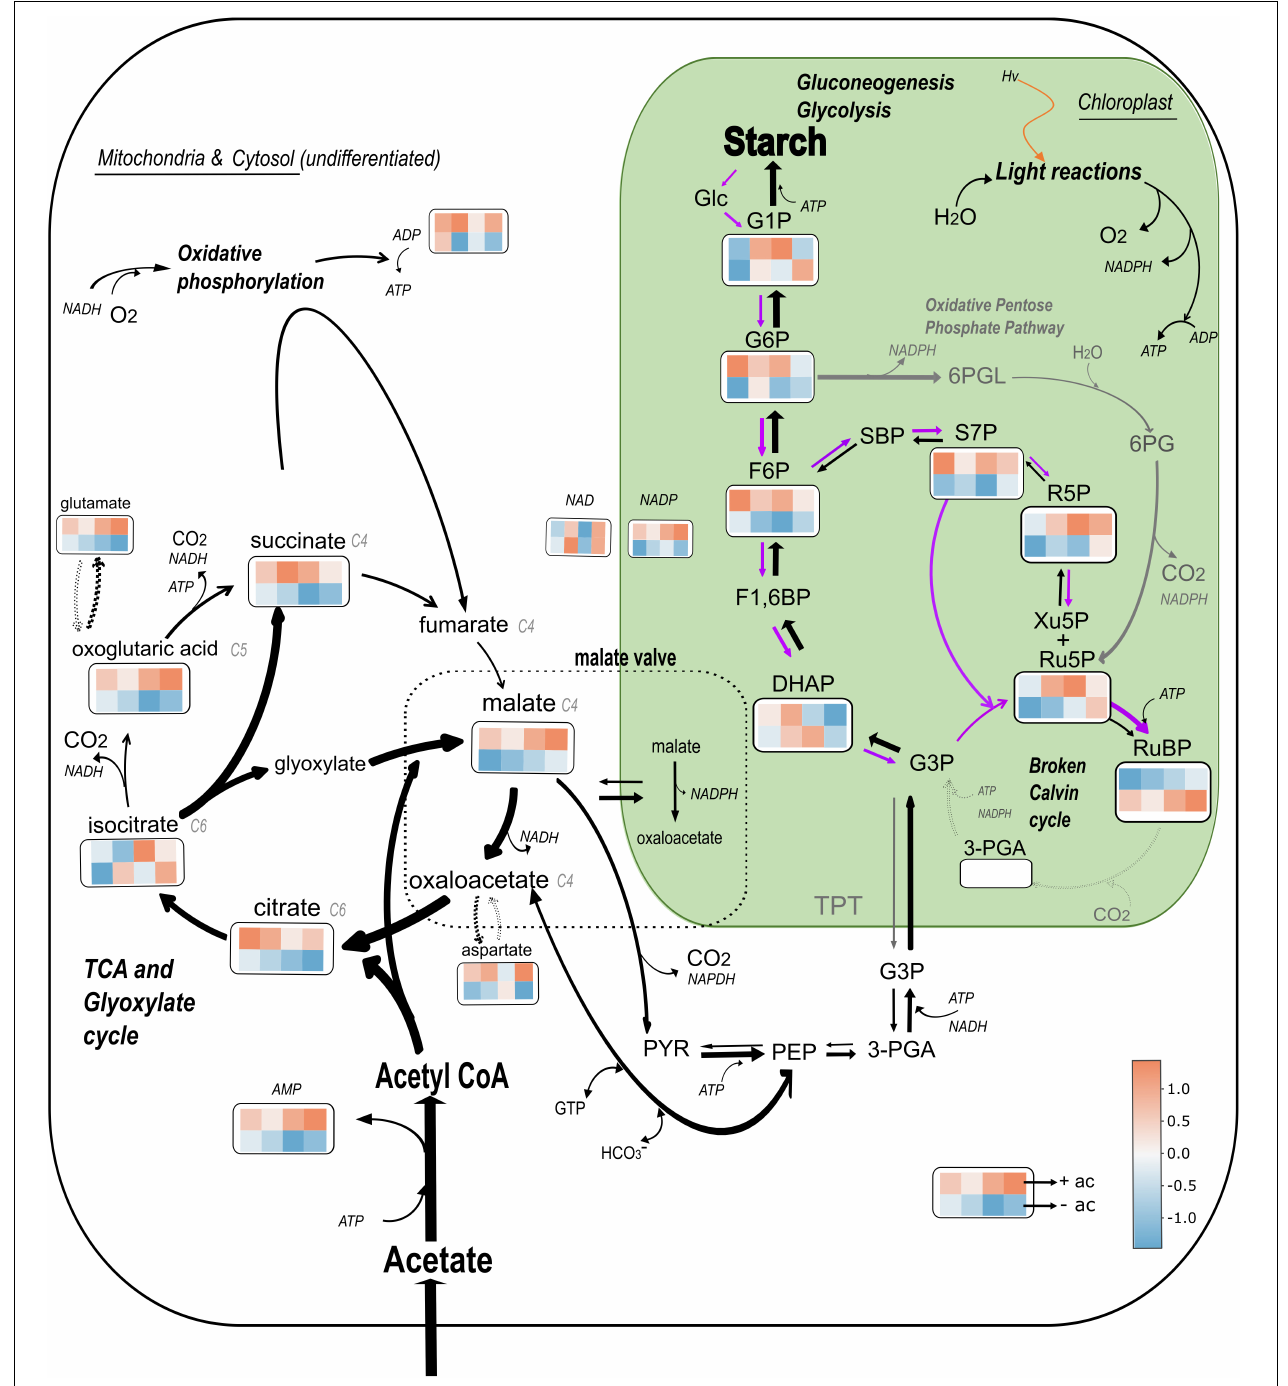
FIGURE 8 | Model of central C metabolism in Chlamydomonas reinhardtii (cid:49) rbcL mutant depending on the carbon status. The relative changes of the abundance of 19 metabolites is represented using colored squares extracted from a heatmap. The top four squares are replicates that represent metabolite abundance in presence of acetate, and the bottom four in absence of acetate, both after a 5 min light treatment (300 µ mol photons m − 2 s − 1 ). The major pathways shown are the glyoxylate and TCA cycles represented together, the gluconeogenic pathway from PYR and PEP to Starch, the Oxidative Pentose Phosphate pathway (gray arrows) and the Calvin Benson Bassham cycle, represented here as “broken” due to the absence of RuBisCO (dotted gray arrows). The width of the black arrows represents the preferential flows in heterotrophic conditions. Purple arrows represents preferential flows in absence of acetate. Glc, glucose; GTP, Guanosine-5’-triphosphate; 6PGL, 6-phosphogluconolactone; 6PG, 6-phosphogluconic acid. Data has been normalized by metabolite and heatmaps have been generated by the heatmaply package on Rstudio. Color is based on correlation coefficient according to the color scale indicated.